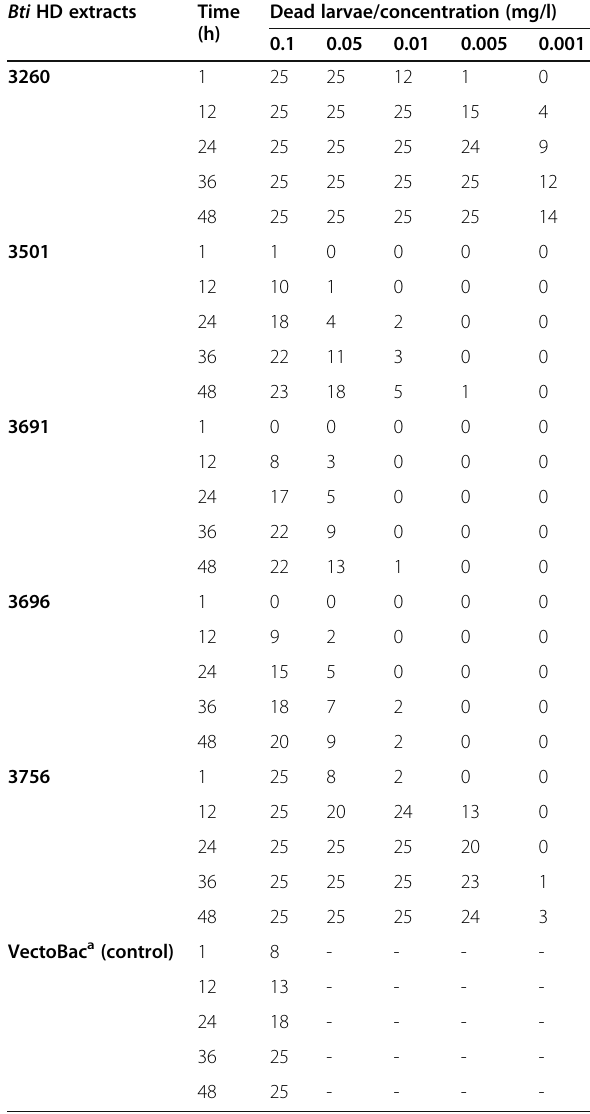
Table 1 Mortality response time from twenty-five Aedes aegypti larvae per concentration. Five different treatments were tested from Bacillus thuringiensis subsp. israelensis ( Bti ) reactivated